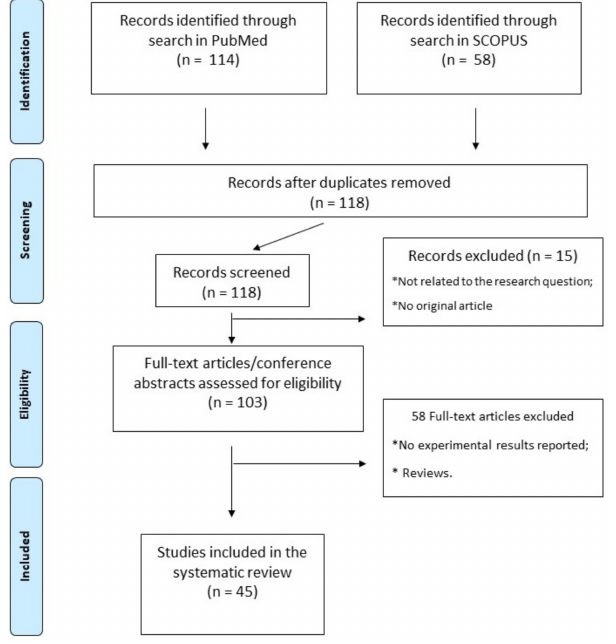
Figure 1. PRISMA flowchart. Article selection flowchart, according to PRISMA